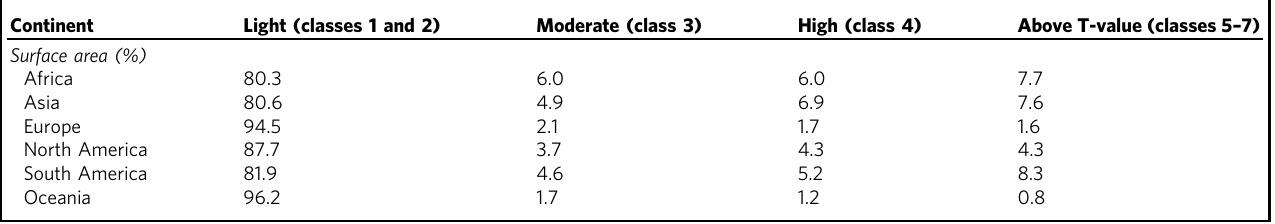
Table 1 Continental perspective on the severity of water erosion in 2012 Continent Light (classes 1 and